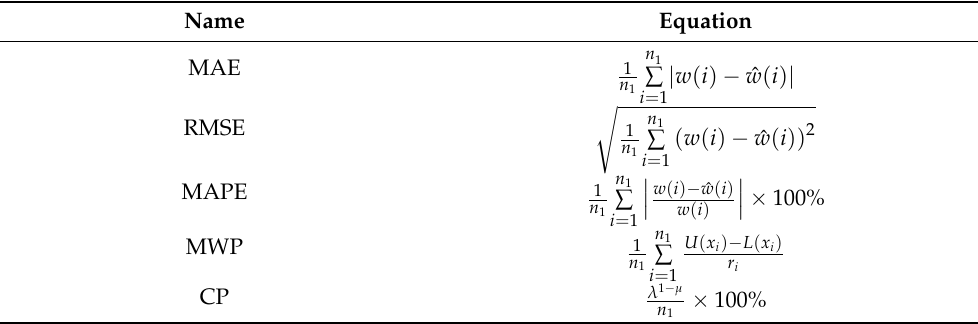
Table 1. The formula of evaluation criteria.